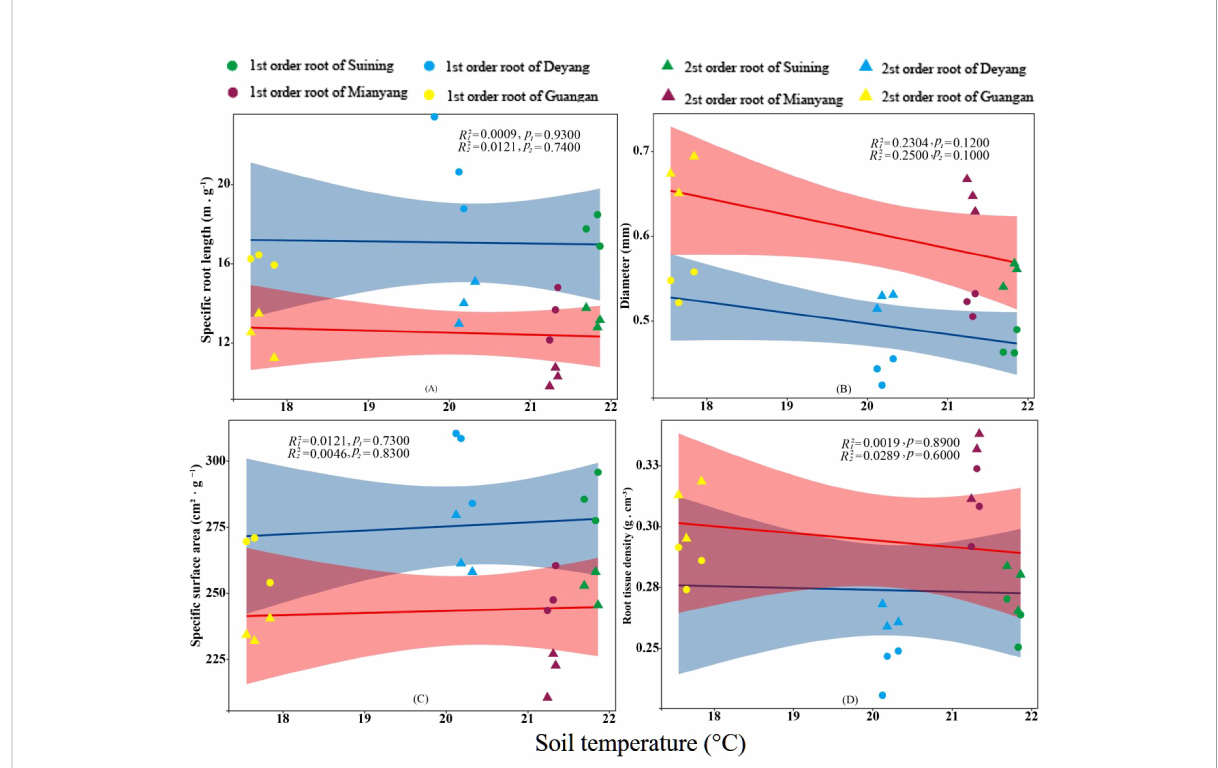
FIGURE 7 Effects of soil temperature speci fi c root length, root diameter, speci fi c root surface area, and root tissue density at four research sites. R 12 and R 2 2 represent coef fi cients of determination for regressions of fi rst- and second-order fi ne roots * and ** indicate signi fi cance at p < 0.05 and p < 0.01, respectively. p 1 and p 2 are p-values indicating signi fi cance of regressions with fi rst- and second-order fi ne roots, respectively. The shaded part is the con fi dence interval of the fi tting line, regimes (n = 3 per